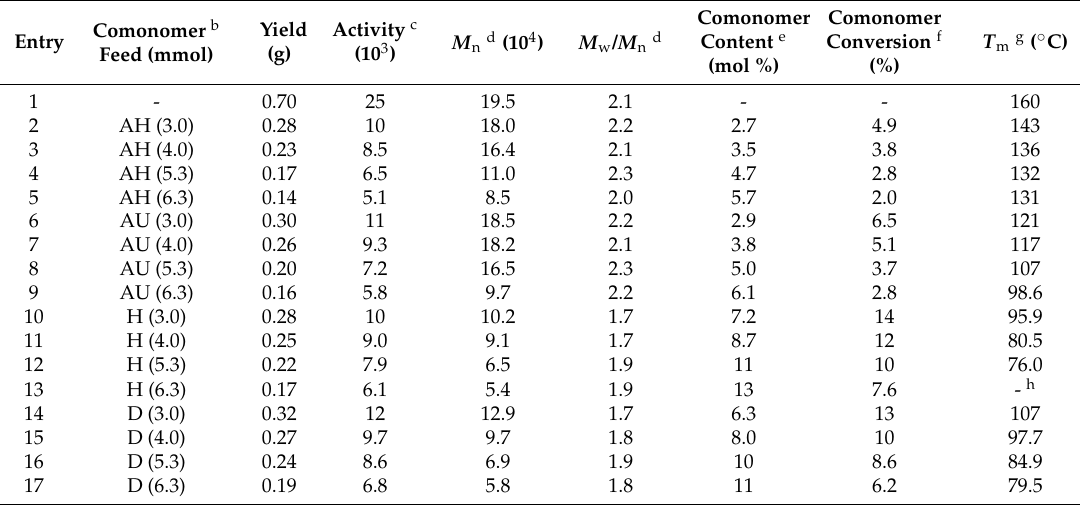
Copolymerizations of propylene with ω -alkenols and higher 1-alkenes